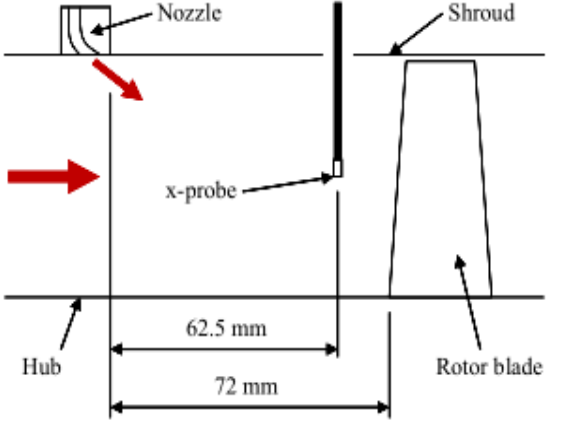
Figure 7. Compressor test equipment [37].